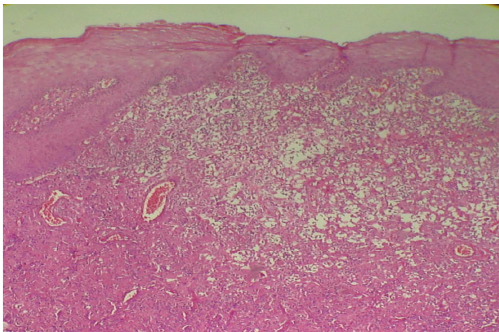
Figure4:Crustonnormalepidermis.Papillaryandreticulardermis with edema and dilated venules and capillaries. Defined mass of eosinophilic cells in the reticular